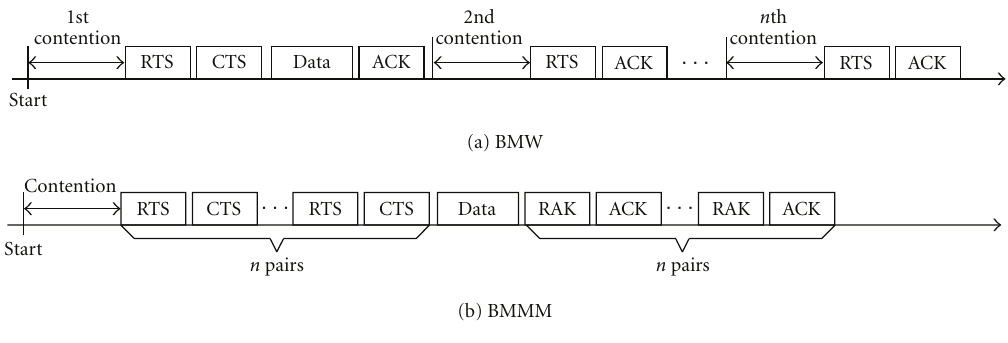
Figure 1: BMW and BMMM